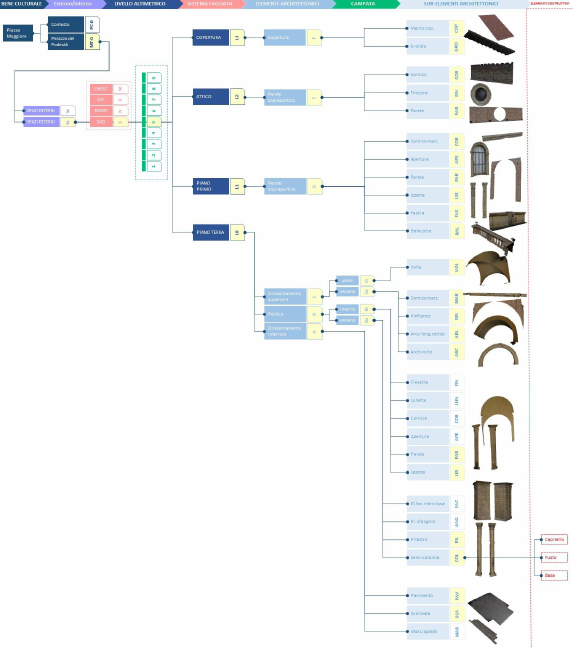
Figure 3. Semantic tree of the 3D model of the Palazzo del Podestà’s portico, Bologna, divided into levels, architectural elements and